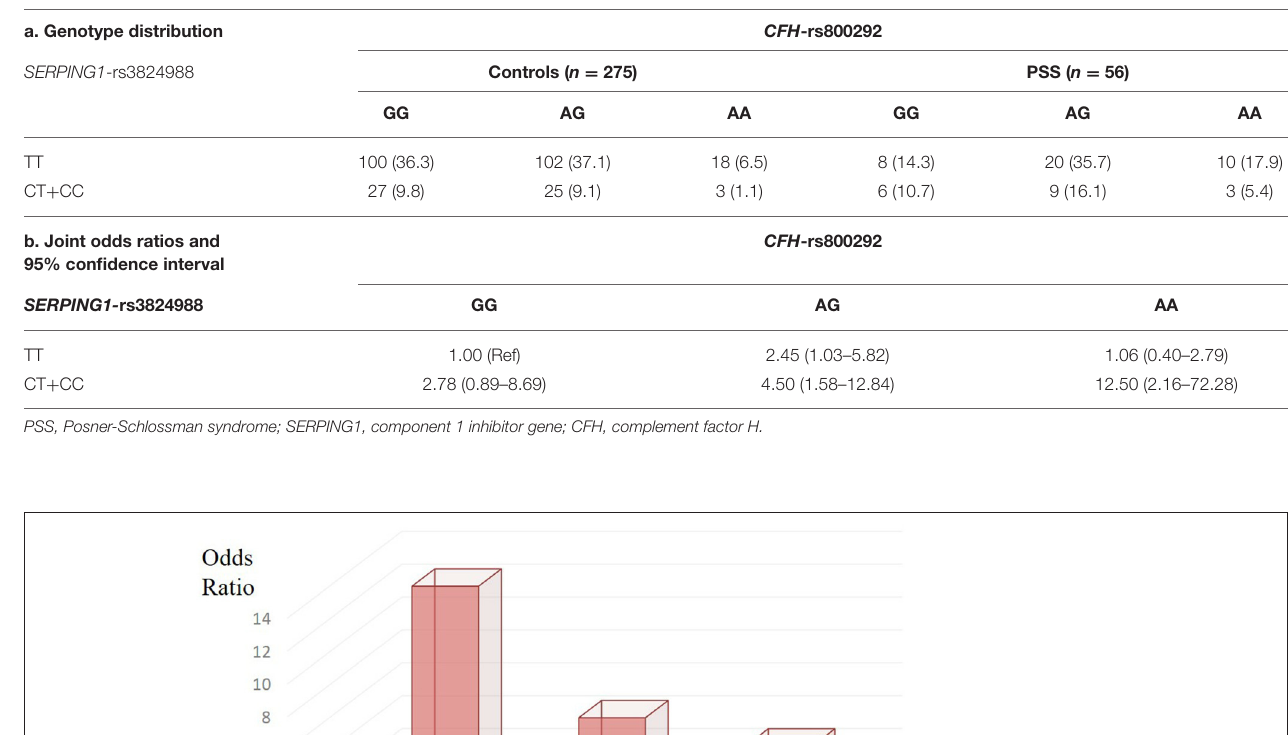
TABLE 5 | Interaction analysis between CFH -rs800292 and SERPING1 -rs3824988.